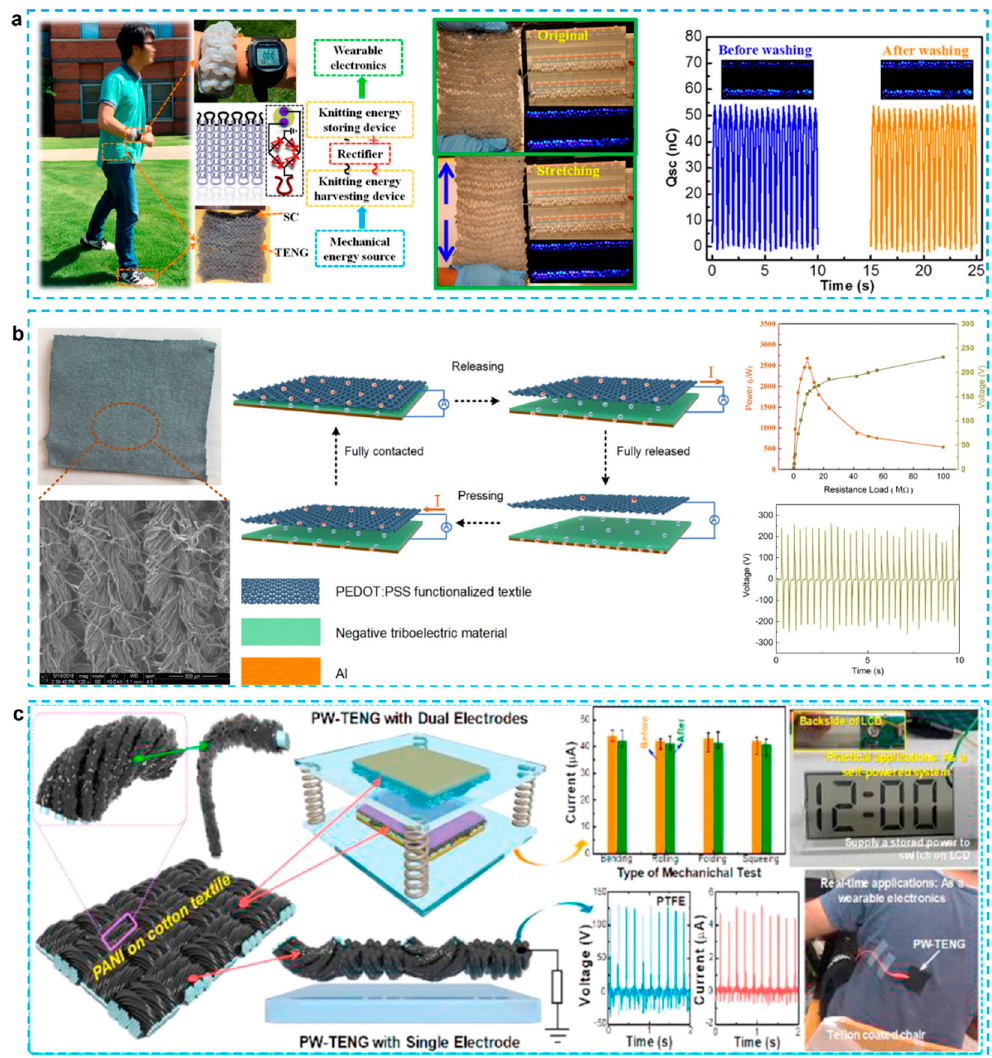
Figure 12. ( a ) A highly stretchable and washable all-yarn-based self-charging knitting power textile composed of fiber triboelectric nanogenerators [105]. ( b ) Multi-functional and PEDOT:PSS based TENG was made from the stretchable smart textiles to harvest energy from various body motions [132]. ( c ) Wearable and durable triboelectric nanogenerators via polyaniline coated cotton textiles as a movement sensor and self-powered system